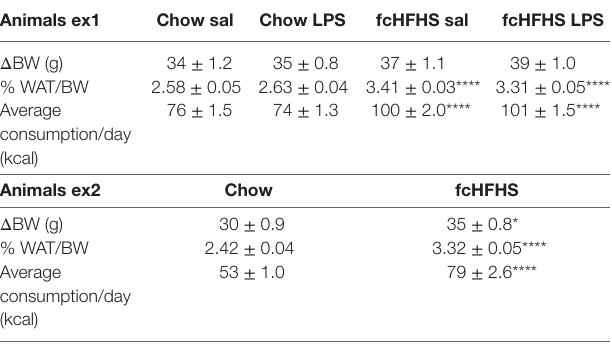
Table 2 | Metabolic characteristics of animals in experiments 1 and